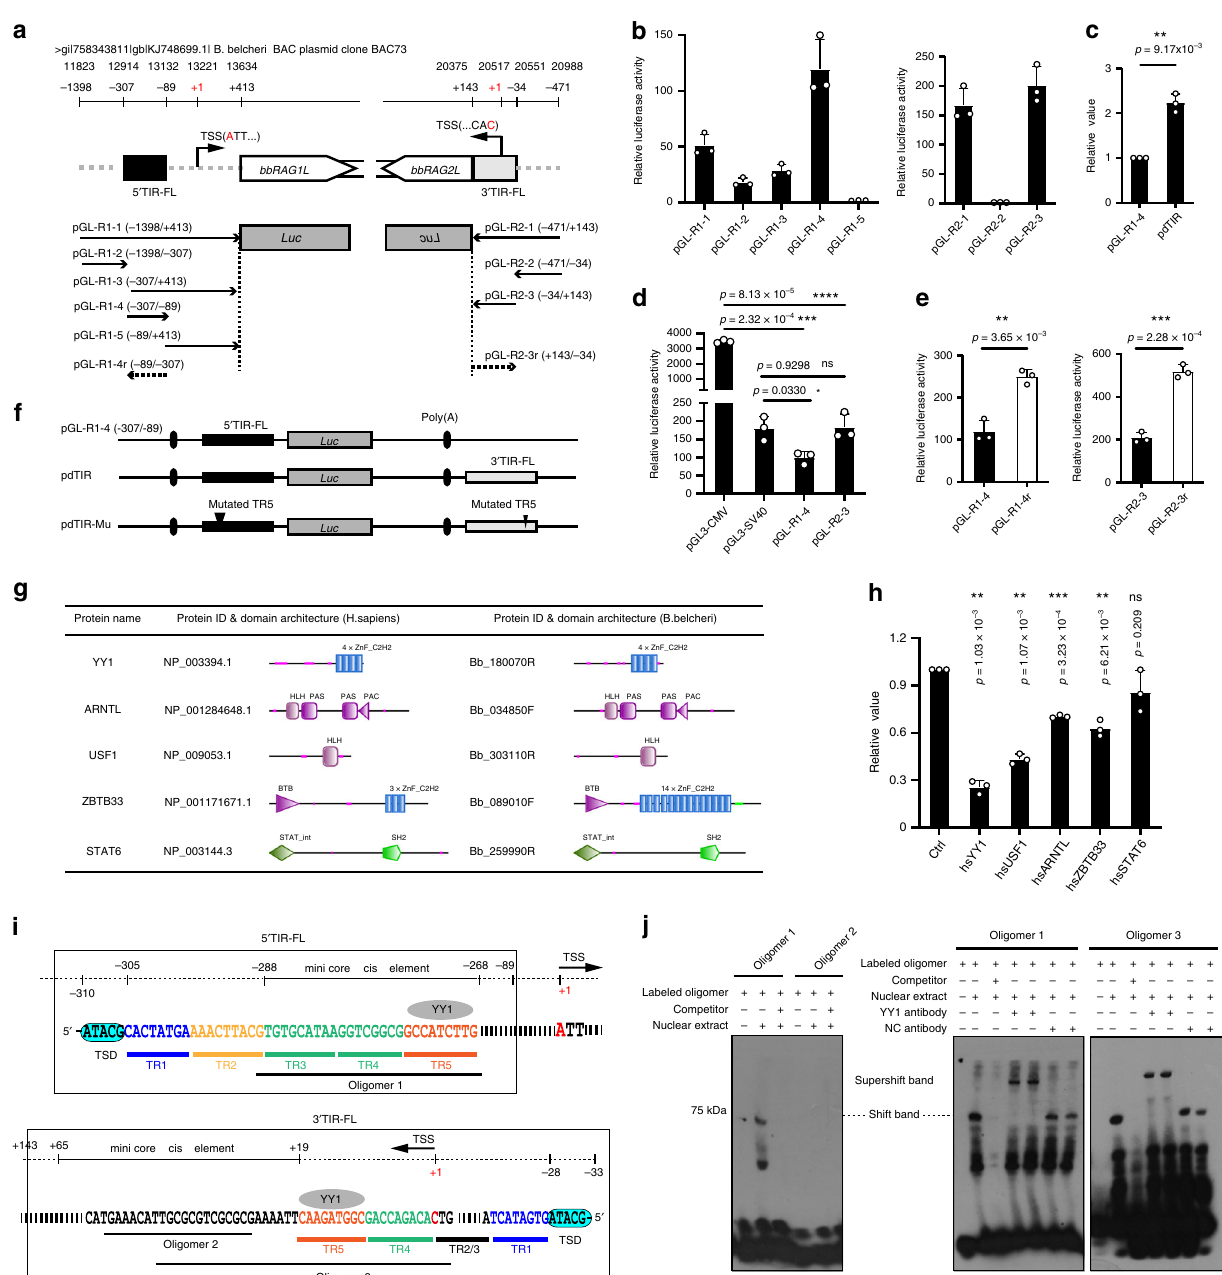
Fig. 1 Identi fi cation of cis -acting elements and YY1-binding motif of ProtoRAG . a Genomic architecture of ProtoRAG on BAC73 clone from B. belcheri BAC libraries and constructs generated for luciferase reporter assay. Potential TSSs are indicated in red. b Luciferase reporter experiments showed that both full-length 5 ′ and 3 ′ TIRs (TIR-FL) of ProtoRAG contain cis- acting elements that may drive the transcription of bbRAG1L and bbRAG2L. See also Supplementary Fig. 1A – D. c The 3 ′ TIR-FL of ProtoRAG can enhance the transcriptional activity of 5 ′ TIR-FL by luciferase reporter experiments. d The luciferase reporter assay indicated that the transcriptional activity of TIR-FL is comparable to that from the SV40 promoter but lower than that from the CMV promoter. e Cis- acting elements in both 5 ′ and 3 ′ TIR-FLs have bidirectional transcription activities according to the analysis of data from luciferase reporter assays. The reporter assays were performed in 293T cells with TIR-containing plasmids, as shown in a . f Schematic diagram of pdTIR and